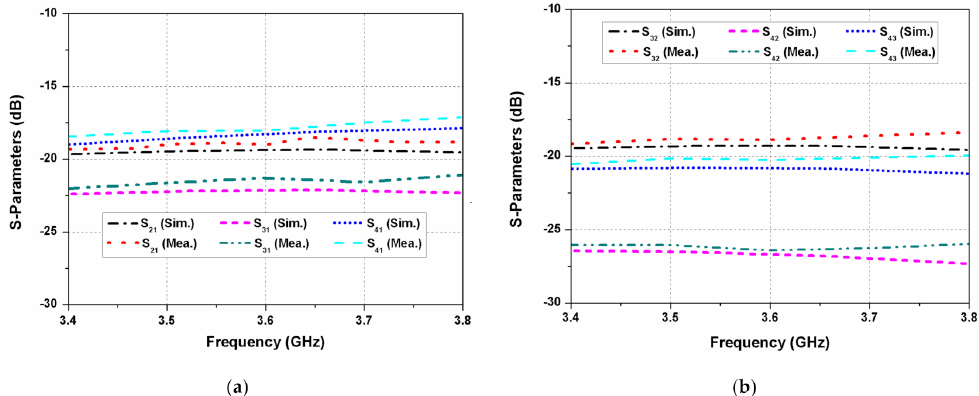
Figure 9. S-parameters of the designed antenna: ( a ) when port 1 is excited; ( b ) when port 2/port 3 is